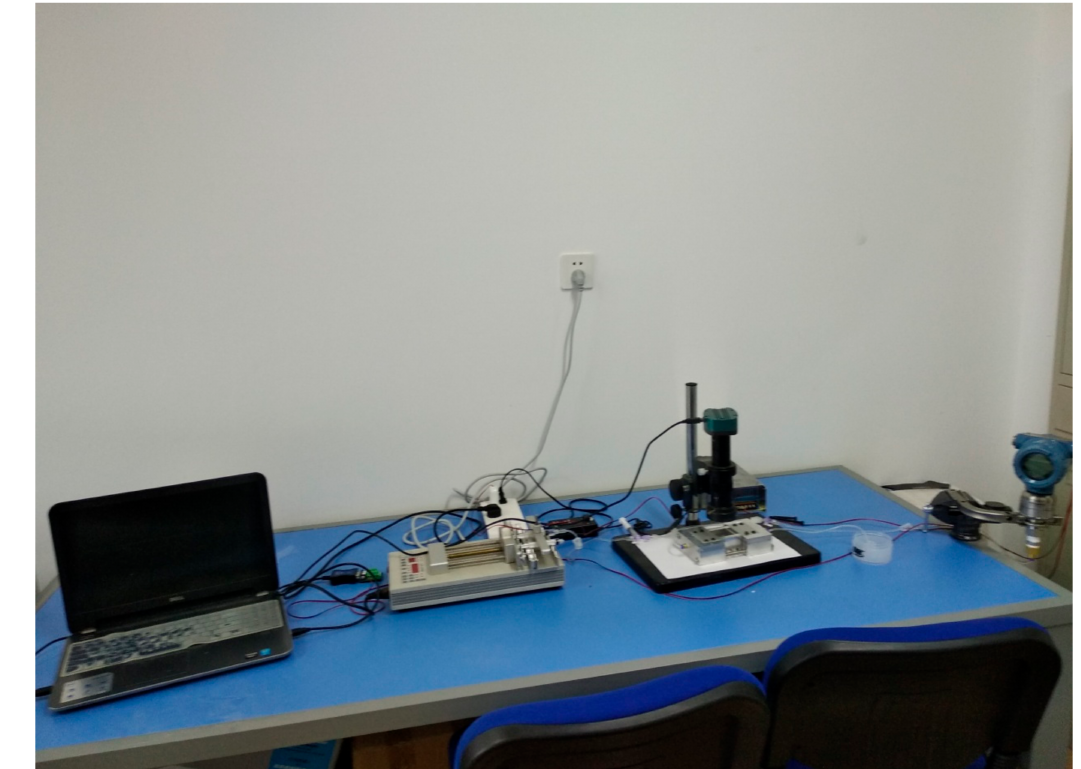
Figure 5. Laboratory